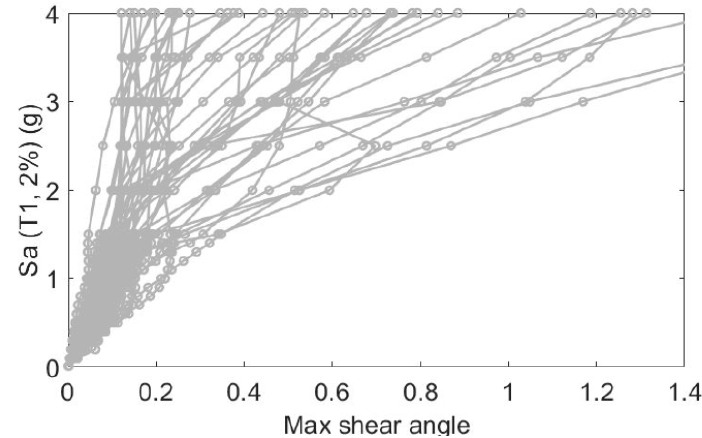
Buildings 2019 , 9 , x FOR PEER REVIEW Figure 9. Incremental dynamic analysis for an EBF system. Figure 9. Incremental dynamic analysis for an EBF system.